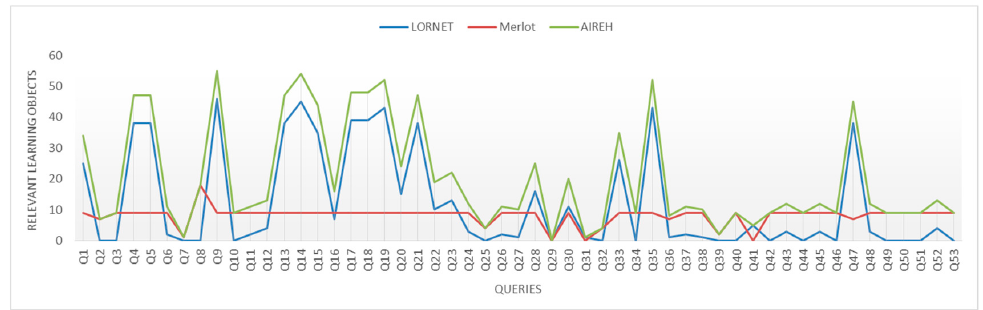
Figure 8. Comparison of relevant metadata documents from learning objects